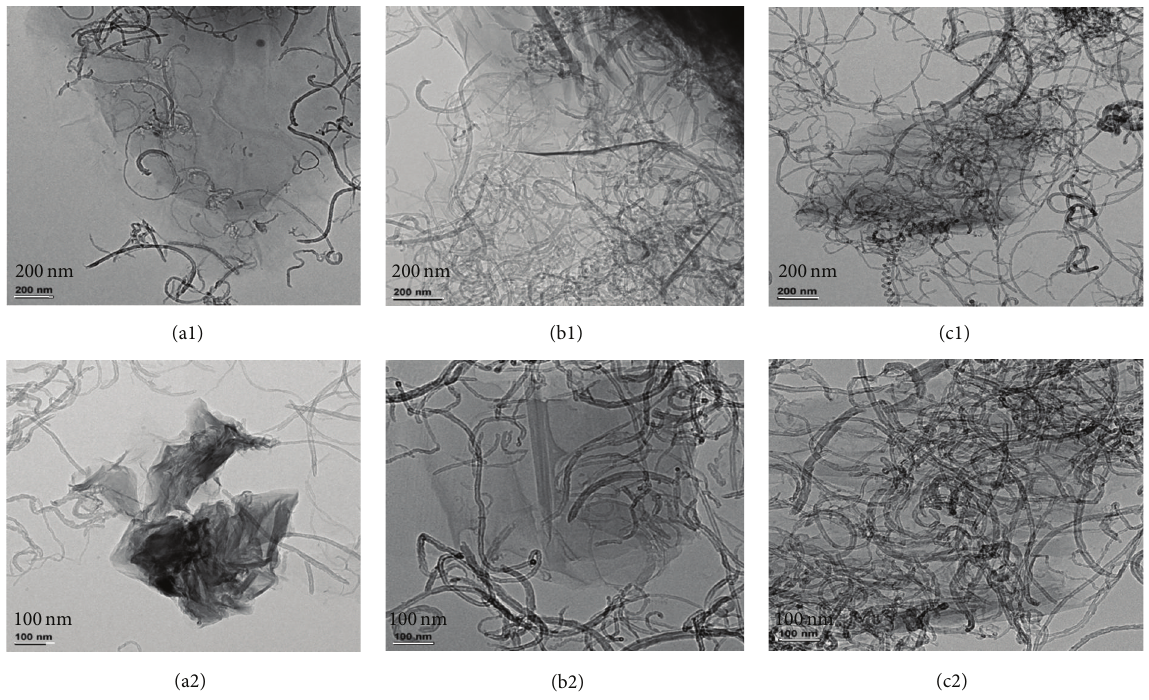
Figure 7: TEM images of G-MWCNTs 3: 1 (a1, a2), G-MWCNTs 1: 1 (b1, b2), and 1 :3 (c1, c2), respectively.